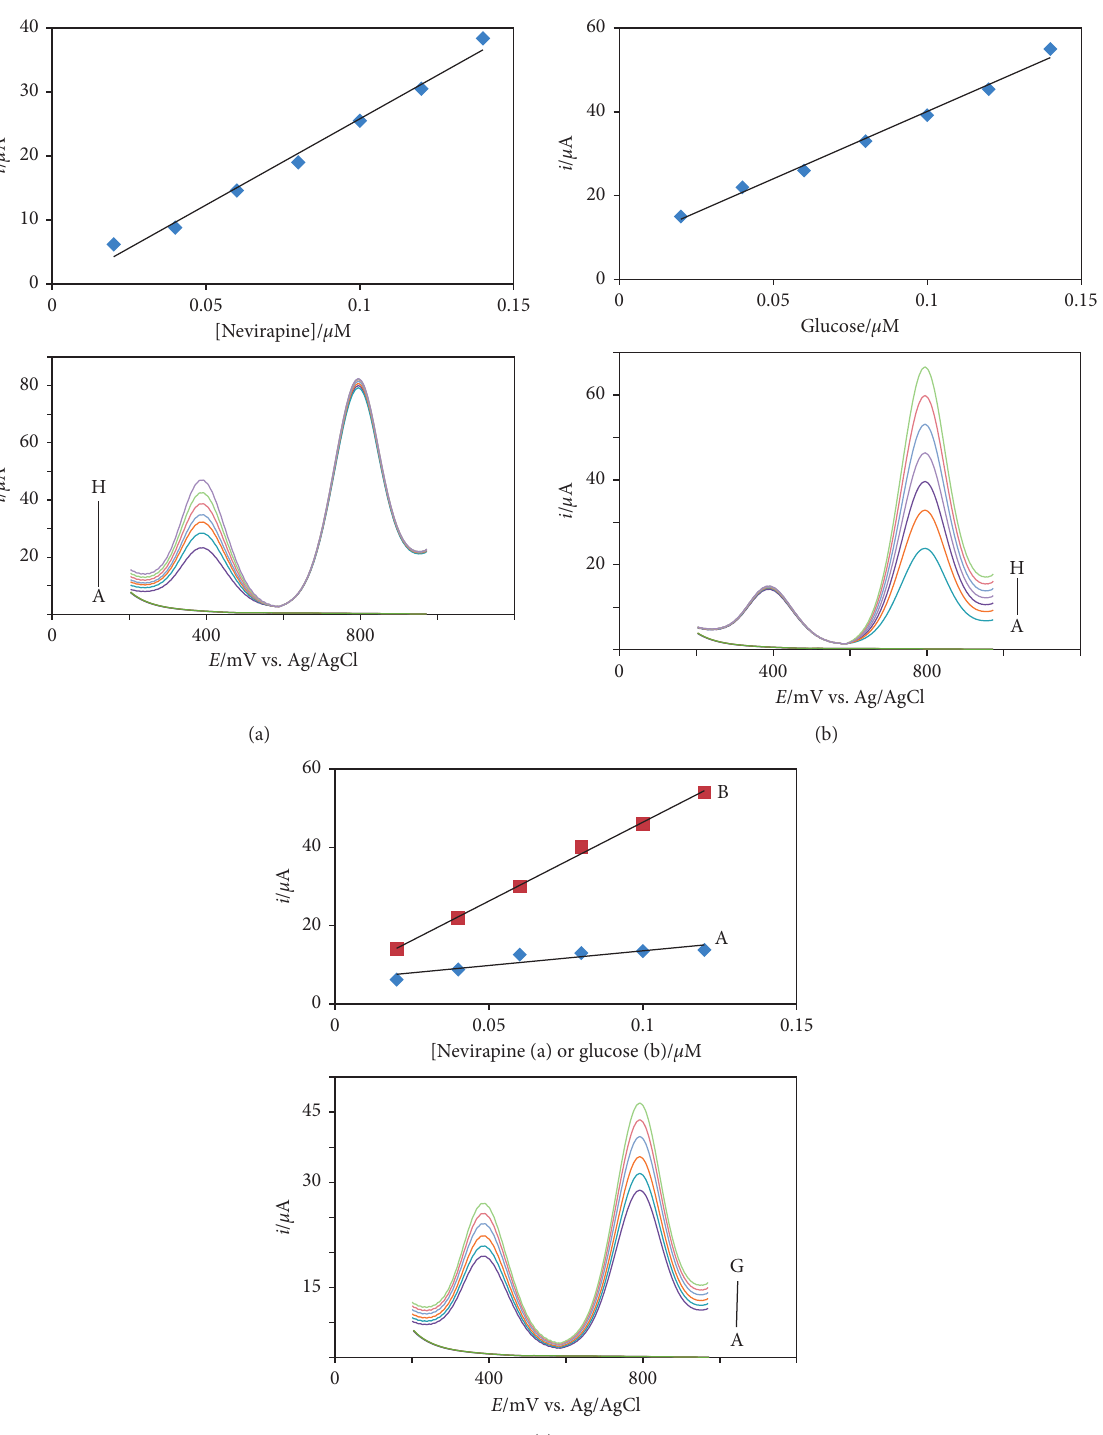
Figure 8: DPVs of TiO 2 /GNR/GCE for (a) 0.2 μ M glucose (kept constant) and different concentrations of nevirapine. Inset plot of i pa ( μ A) versus [nevirapine]/ μ M; (b)0.2 μ M nevirapine (kept constant) and different concentrations of glucose. Inset : plot of i pa ( μ A) versus [glucose]/ μ M; (c) DPV for different concentrations of nevirapine and glucose, all in 0.1M PBS solution, pH 11.0. Different concentrations ranged from 0.02 to 0.14 μ